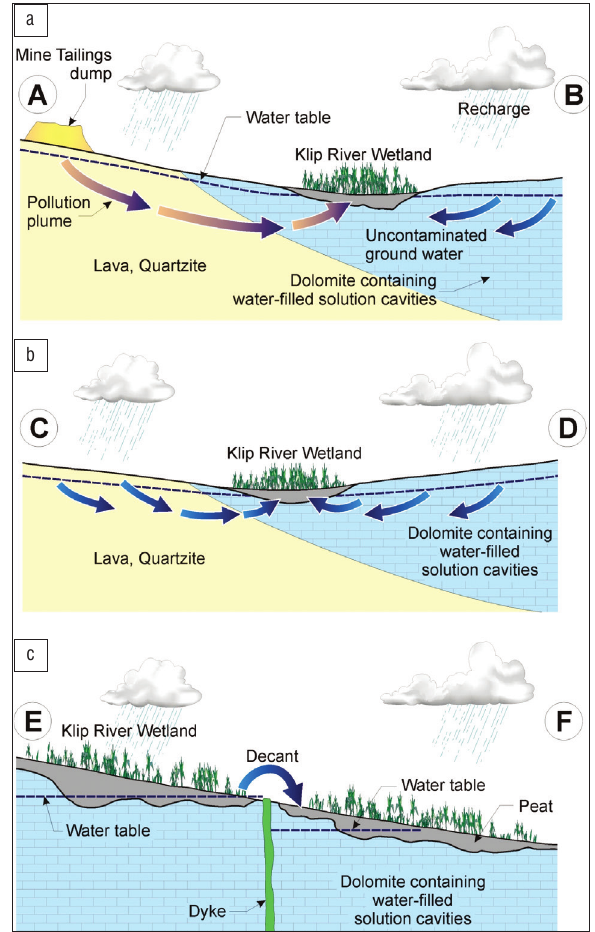
Figure 3: Schematic diagrams showing (a) the ingress of polluted ground- water into the karst-hosted Klip River wetland, (b) the recharge of groundwater in the karst-hosted Klip River wetland and (c) the flow of water from one dolomitic compartment to another across a bounding dyke. The down-channel gradient has been greatly exaggerated in this sketch. See Figure 2b for approximate profile